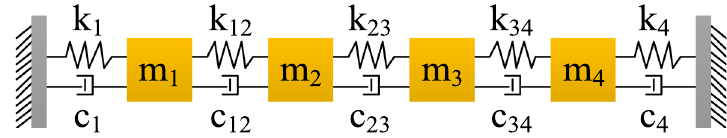
Fig. 3 Four degree-of-freedom linear spring-mass-damper